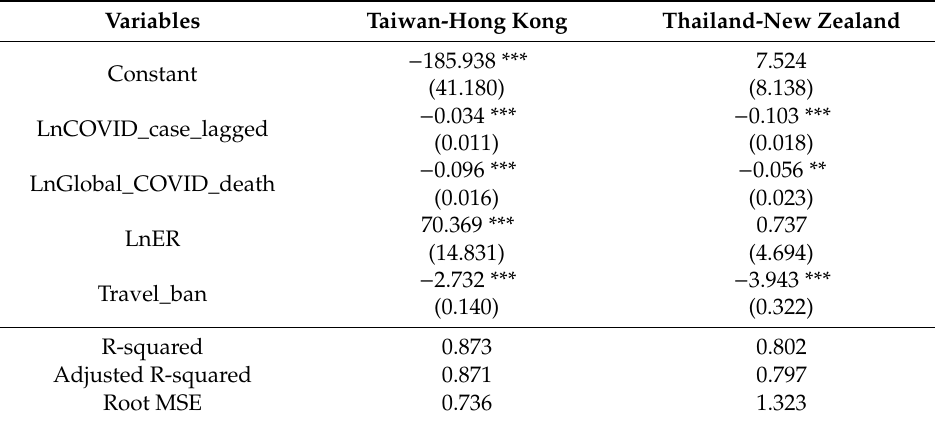
Table 5. Results of panel fixed e ff ects models for two economy